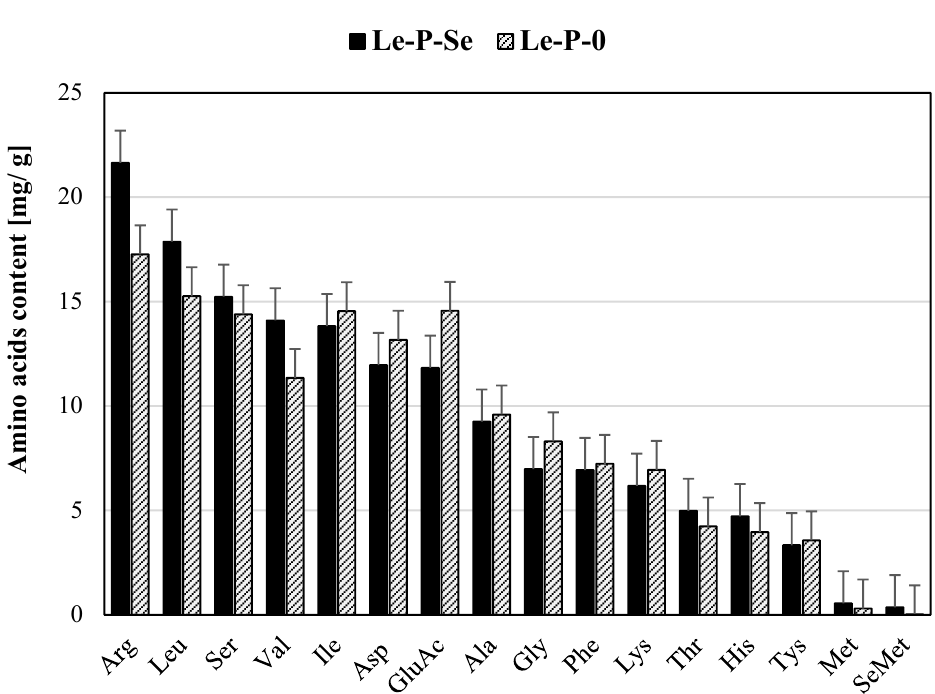
Figure 5. Amino acid composition of Se-exopolysaccharides and the reference fraction.